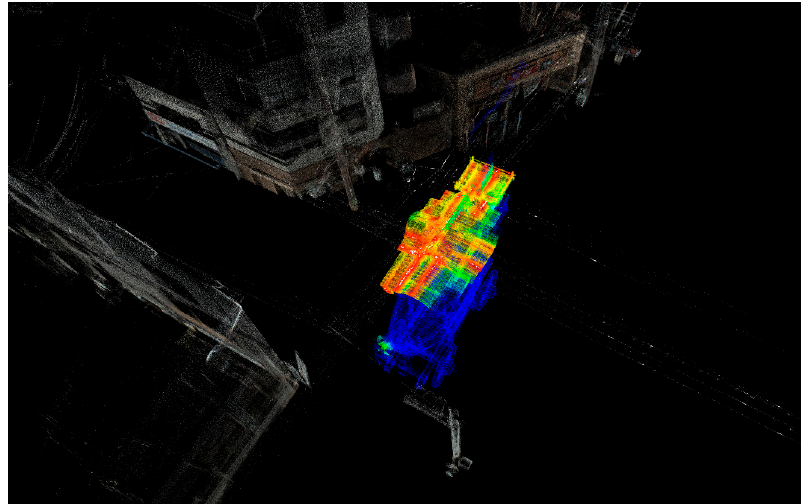
Figure 11. Transparent visualization of the Ofune-hoko when it collides with electric wires. The total number of points that is used for the visualization is 1.02 × 10 7 . The ground surface data are removed to avoid the intersection of the float with the ground surface.